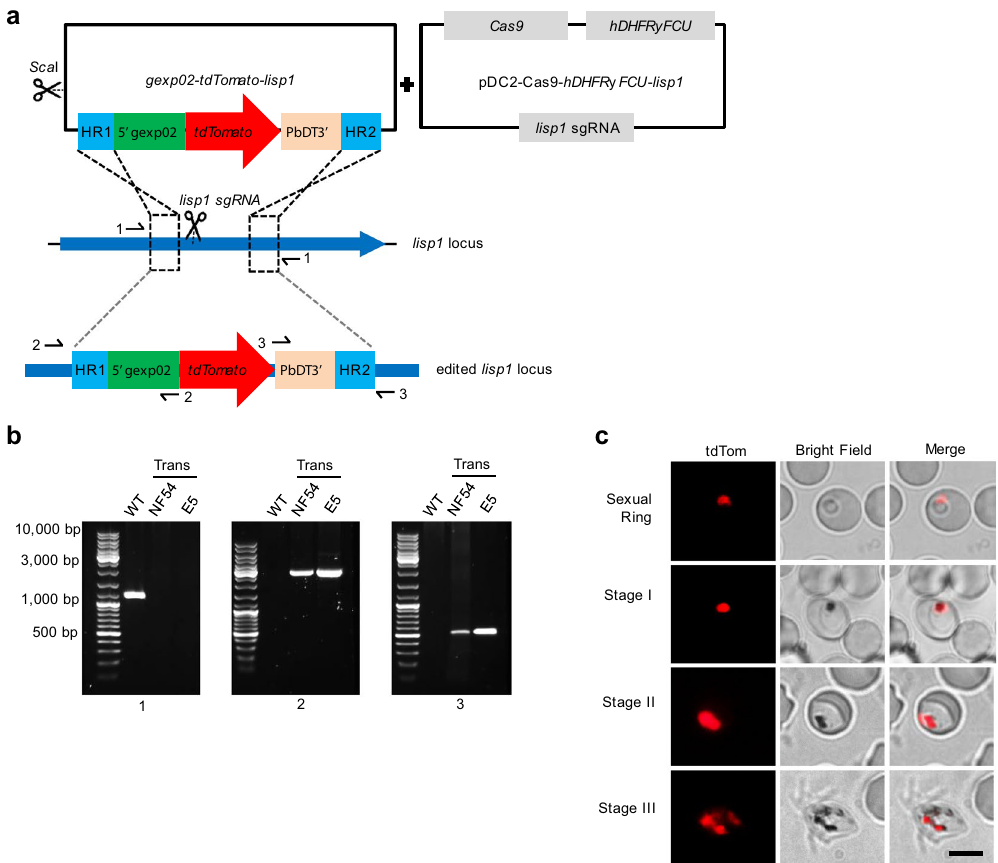
Figure 1. Generation and validation of gametocyte-reporter lines based on the gexp02 promoter. ( a) Schematic of the strategy to generate the transgenic lines using the CRISPR/Cas9 system. Half-arrows indicate the position of primers used for diagnostic PCR. (b) Diagnostic PCR confirmation of the integration of the gexp02- tdTomato-lisp1 plasmid at the lisp1 locus. Numbers at the bottom indicate the primer pair used for each PCR reaction. Genomic DNA from the wild type E5 line (WT) or the NF54 and E5 transgenic lines (Trans) was used. The size of the bands was as expected for the wild-type (1,184 bp for PCR 1) or correctly-edited locus (2,875 bp for PCR 2 and 550 bp for PCR 3). The size of the most intense and top bands of the size marker is indicated. A PCR product was not amplified with primer pair 1 in the transgenic lines, likely because of the too large size of the expected amplification product. (c) Live cell fluorescence microscopy analysis of induced (choline- depleted) NF54-gexp02-Tom cultures, revealing a subset of tdTom-positive cells consistent with the sexual ring stage (no detectable hemozoin pigment) (top panel). At days 1 to 3 after N-acetyl-D-Glucosamine (GlcNAc) treatment, tdTom signal was observed in parasites morphologically resembling gametocytes at different stages of development (other panels). Scale bar: 5 µ